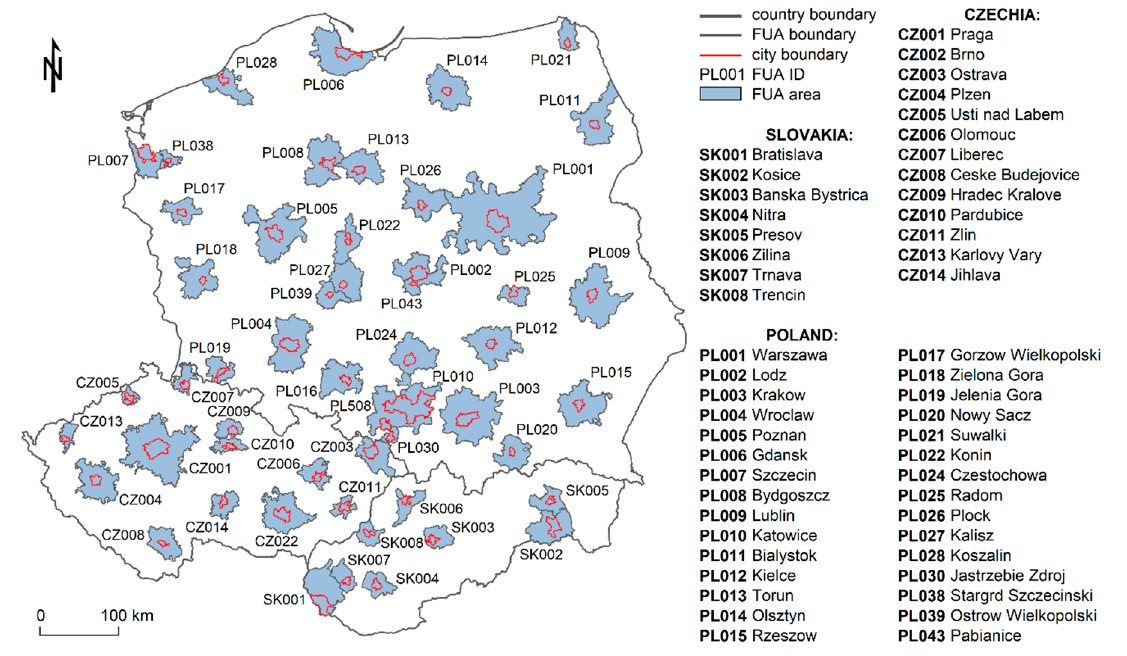
Figure 1. Locations and codes of the investigated functional urban areas (FUAs) in Poland, Czechia, and Slovakia.